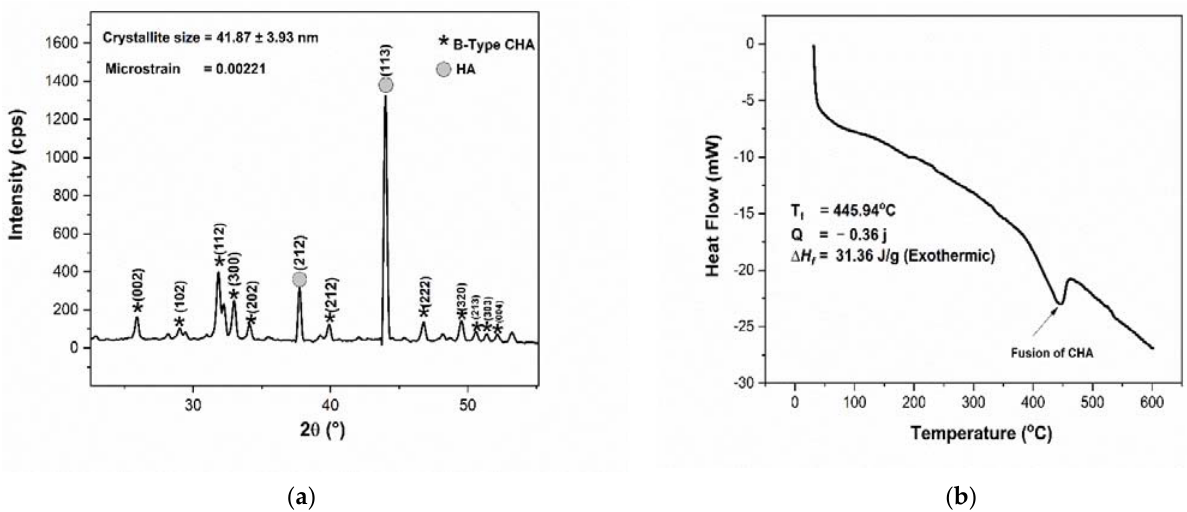
Figure 4. ( a ) Analysis of CHA with stirring time of 45 min: ( a ) XRD pattern; ( b ) temperature of fusion.